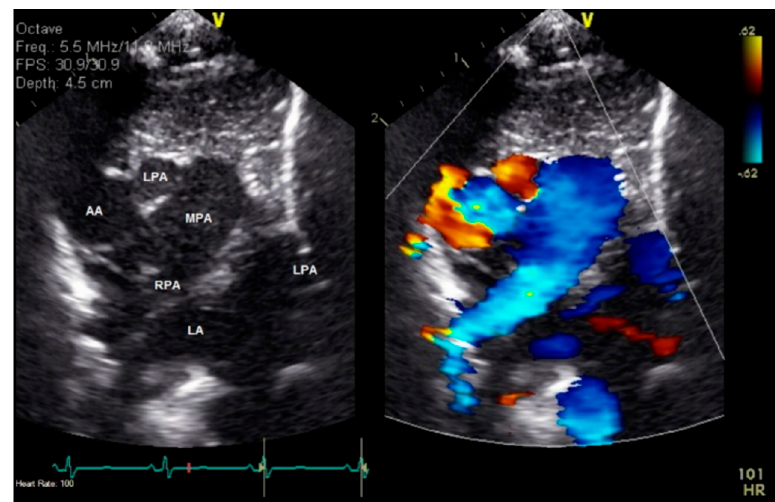
Figure 2. Echocardiography in the high-right parasternal short-axis view. The left panel is a two- dimensional image while the right panel is color interrogation of the same image. The pulmonary trunk is seen giving rise to a right pulmonary artery, without evidence of another vessel branching from the pulmonary trunk. The ascending aorta is visualized posterior and rightward, and there is an additional structure noted between the ascending aorta and the pulmonary trunk that appears to course anteriorly from the ascending aorta. This was confirmed by additional imaging to be the left pulmonary artery arising from the ascending aorta. The left pulmonary artery can be seen arising from the ascending aorta and then coursing leftward, crossing the pulmonary trunk and the right pulmonary artery in its course.